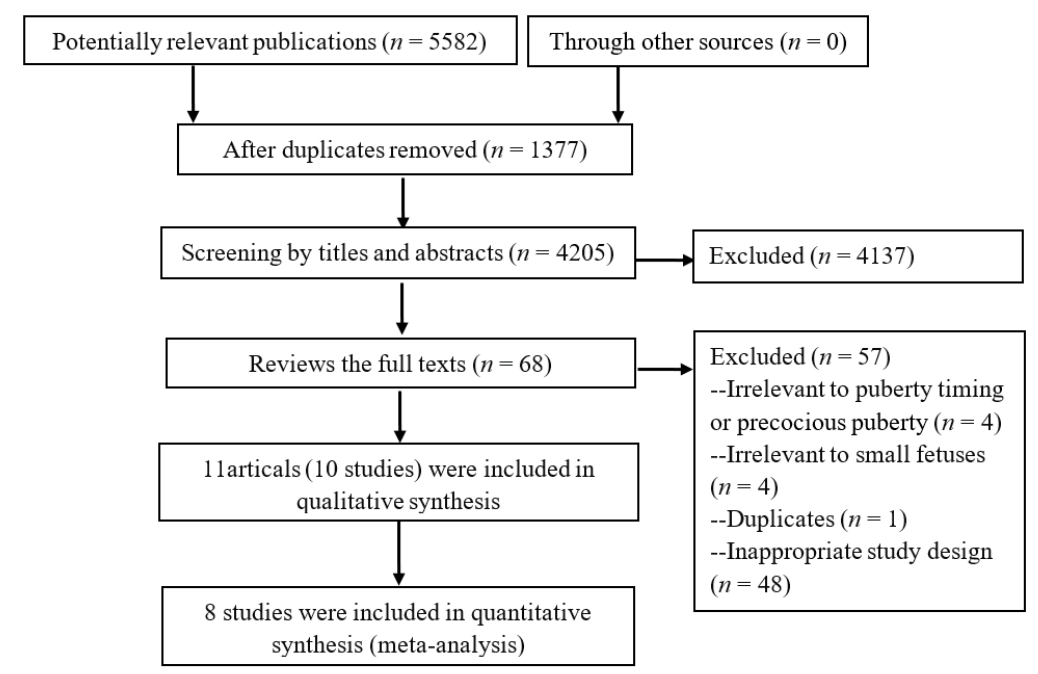
Figure 1. Flow diagram of literature search.